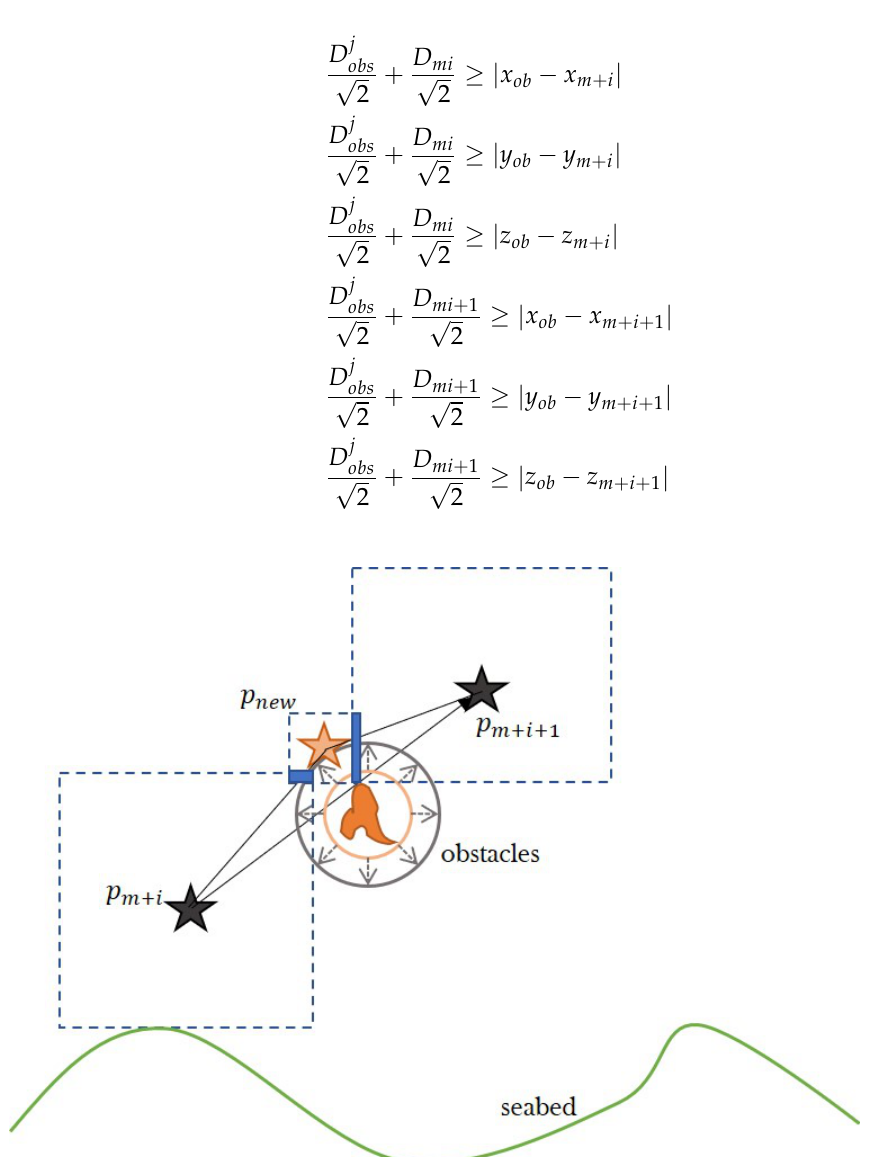
s and p (cid:48) s . In this condition, if the m + i m + i + 1 s and p (cid:48) s corridor, then the spots will be recorded as m + i m + i + 1